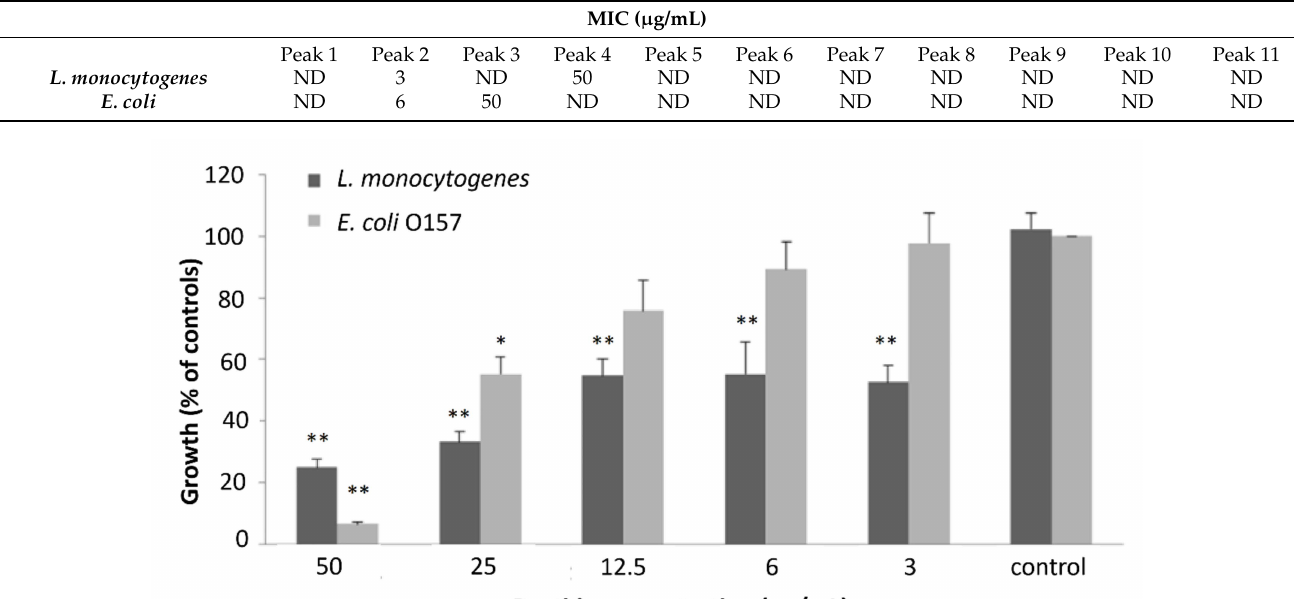
Table 2. Minimal inhibitory concentrations (MICs) of the different peaks collected by HPLC separation of the day 6 fermented whey against the growth of the model species L. monocytogenes and E. coli O157. MICs were determined as the concentration required to induce 90% bacterial growth. Values are expressed in µ g/mL for each peak collected. ND = not detected for the highest concentration used in this assay (50 µ g/mL).